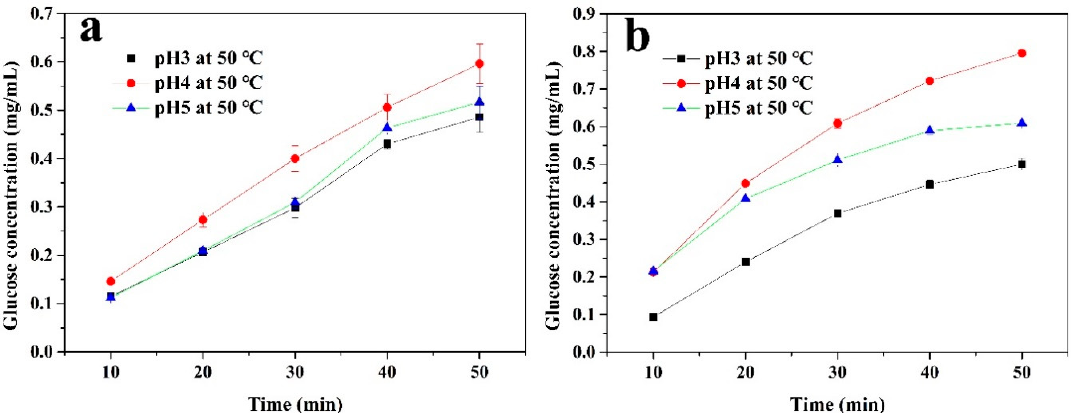
Figure 7. The glucose produced from the ( a ) immobilized and ( b ) free cellulase by hydrolyzing a 1% carboxymethyl cellulose sodium (CMC) solution at 50 °C with different pH values for 50 min.